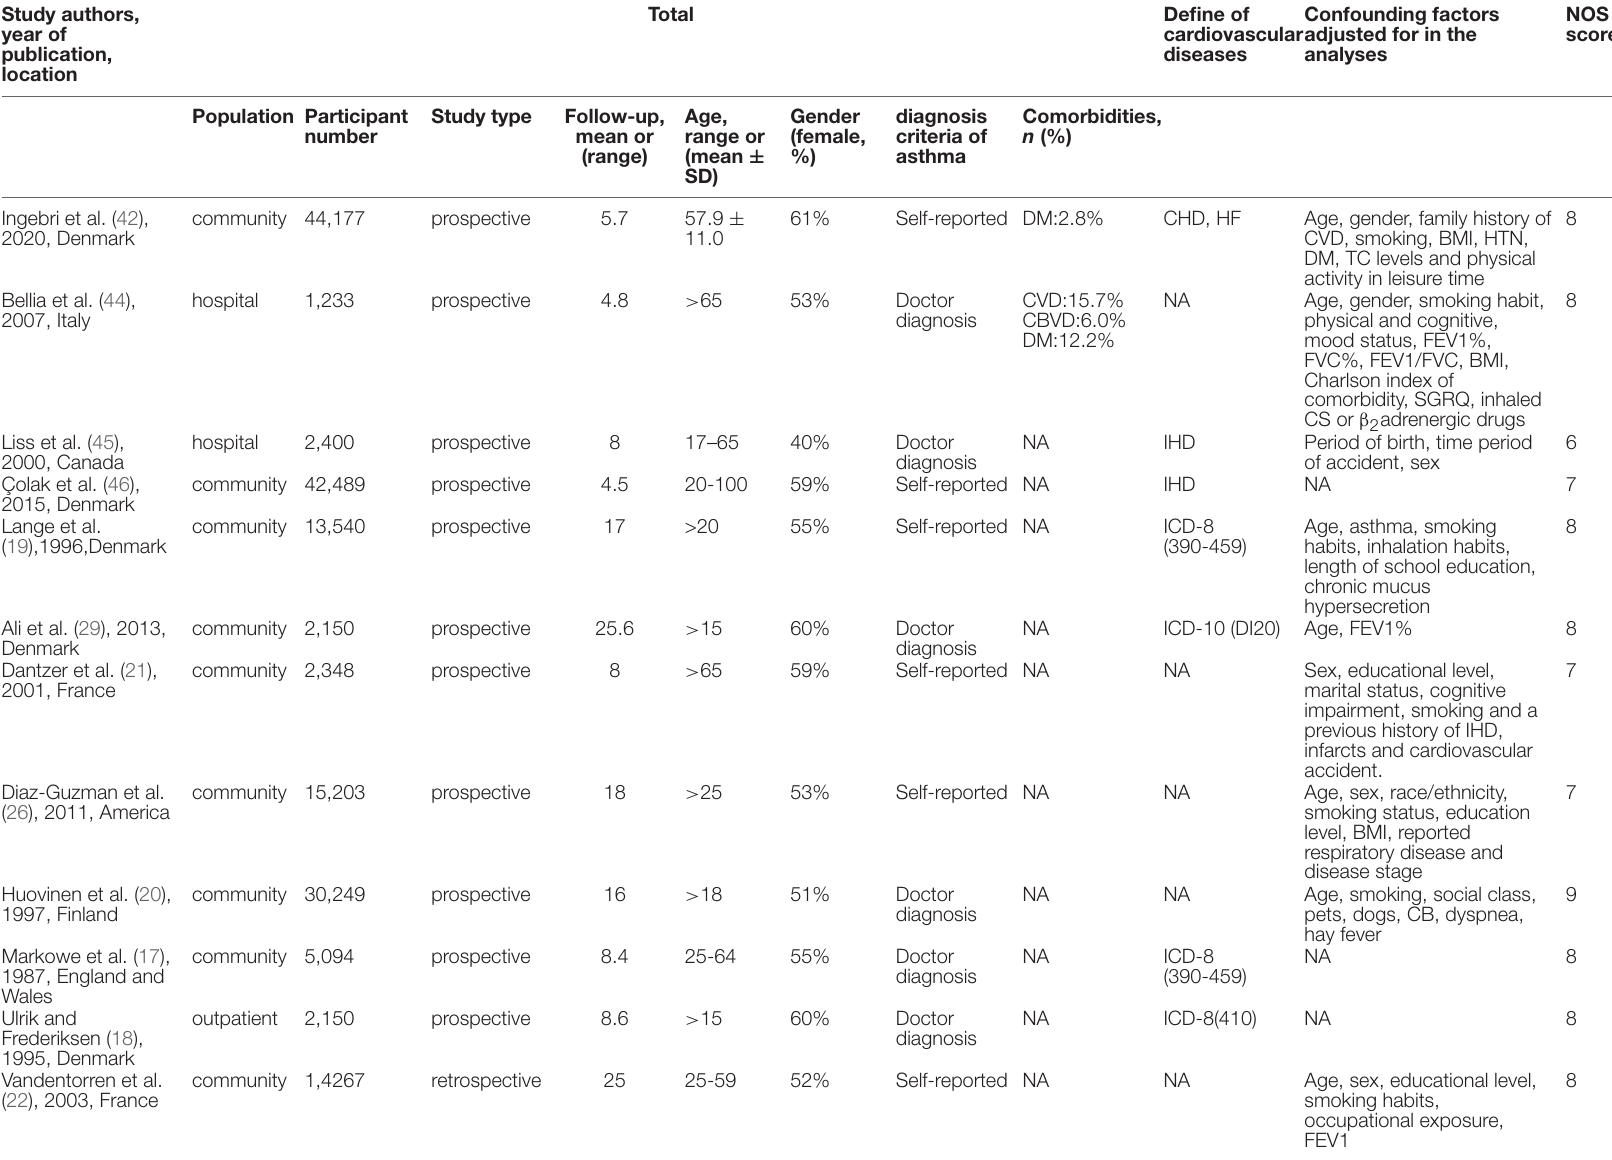
TABLE 1 | Baseline characteristics of participants assessed in the studies included in the